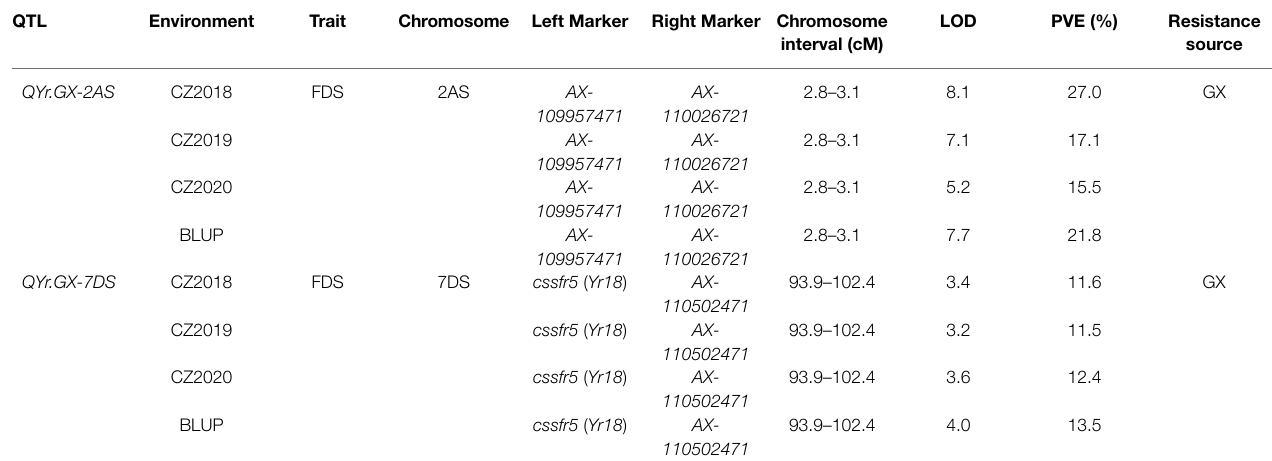
TABLE 2 | Quantitative trait loci (QTL) for stripe rust resistance detected in the recombinant inbred lines (RILs) population from the Gaoxianguangtoumai (GX) × Taichung 29 (TC 29) using final disease severity (FDS) data across three environments and best linear unbiased prediction (BLUP) values. QTL Environment Trait Chromosome Left Marker Right Marker Chromosome interval